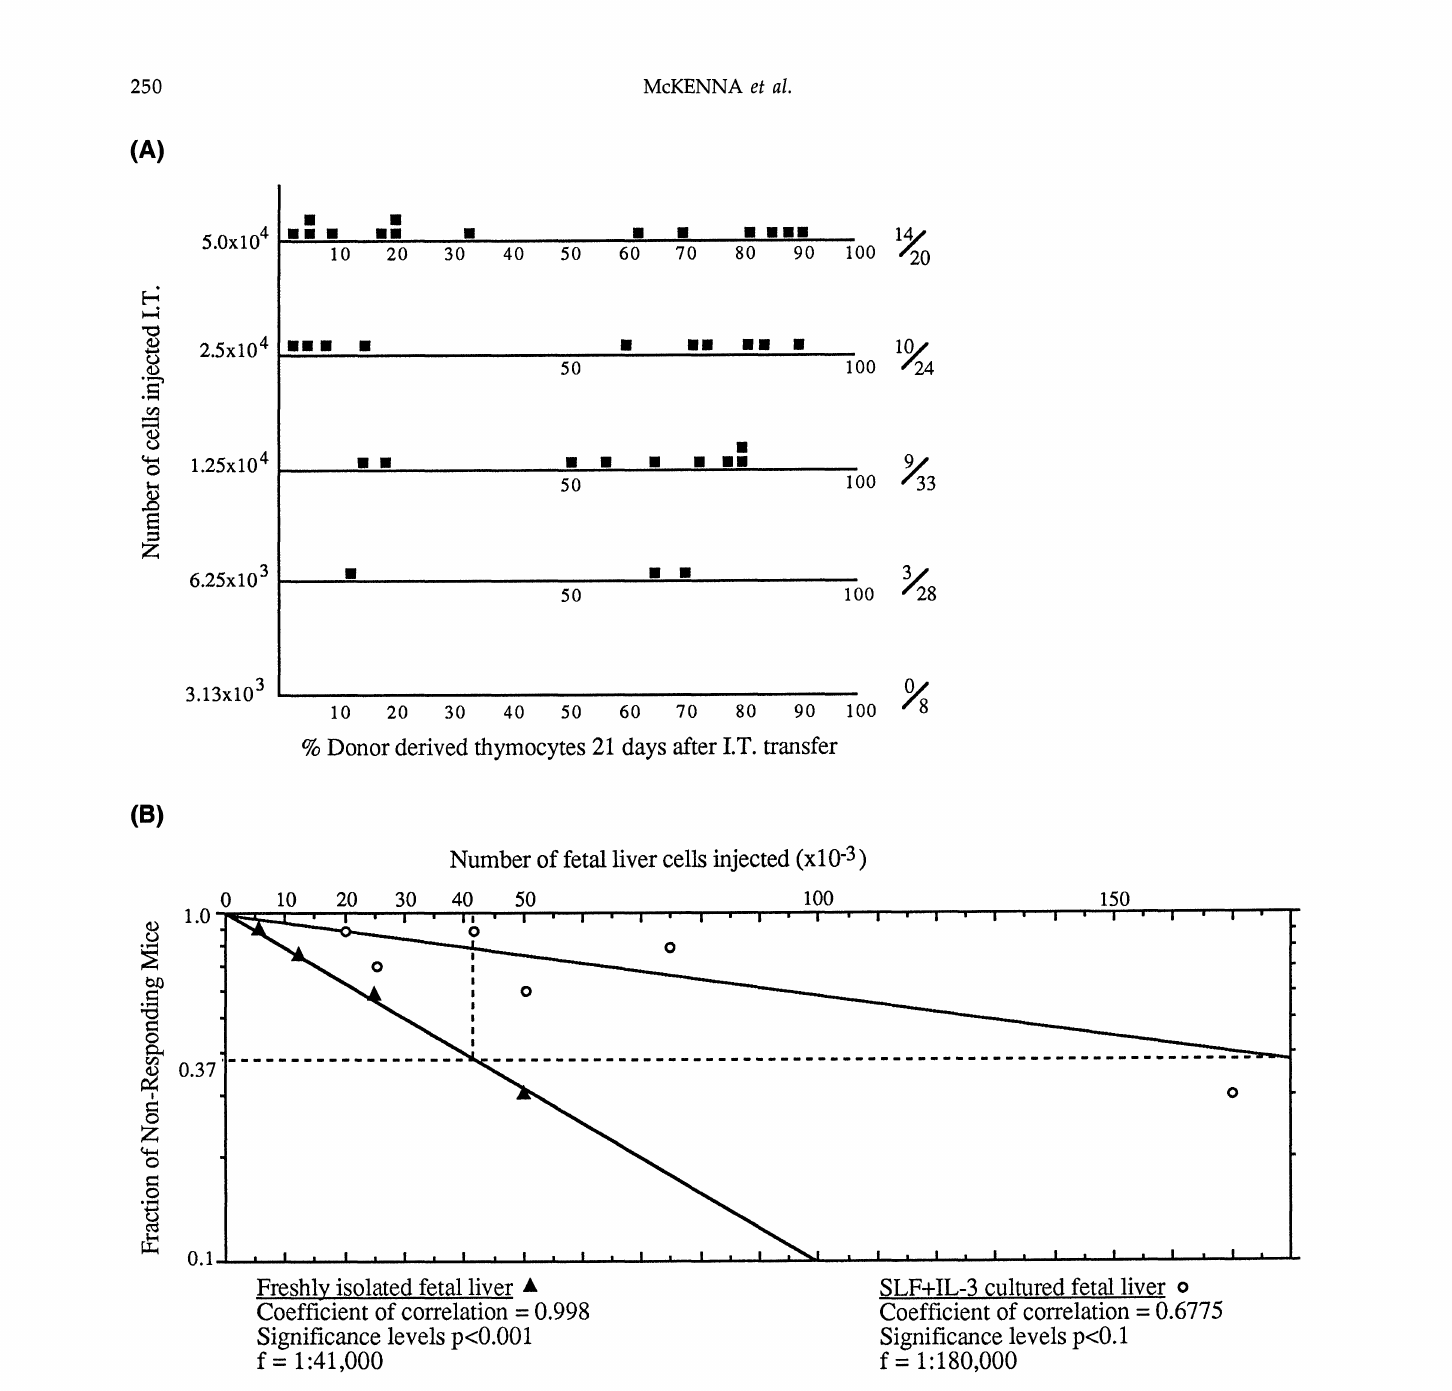
FIGURE 2. (A) The effect of limiting cell numbers on thymic lobe reconstitution. Sublethally irradiated C57BL/Thyl.1 adult mice were intra-thymically injected with limiting numbers of day-12 C57BL/Thy1.2 fetal liver cells, ranging from 5 X 104 down to 3.13 x 103 cells. Twenty-one days after injection the mice were sacrificed and the proportion of Thyl.1 and Thyl.2 cells was determined in the injected lobe. Any lobe showing greater than 1% Thyl.2 cells at day 21 was scored as showing repopulation. (The solid square represents one mouse, and the fractions to the right denote the number of mice showing repopulation relative to the number injected.) (B) Poisson analysis of the limit dilution data. The fraction of non-repopulated mice from Fig. 2(A) was plotted against the number of cells injected (solid triangles). Poisson analysis of limit dilution performed with SLF + IL-3 cultured fetal liver: Day- 12 fetal liver cells from C57BL/Thy1.2 embryos were isolated and placed in culture supplemented with SLF + IL-3 as for Fig. 4. After 7 days, the cells were harvested and the viable cells counted. The increase in net cell number was noted. Numbers ranging from 1.7x 105 down to 2.08x104 were injected I.T. and the mice were sacrificed and analyzed on day 21. Fifty-seven mice were analyzed. The fraction of nonrepopulated mice were plotted against the number of cells injected (open circle). (The solid square is the frequency of TSC in adult bone marrow. Each group contained 20